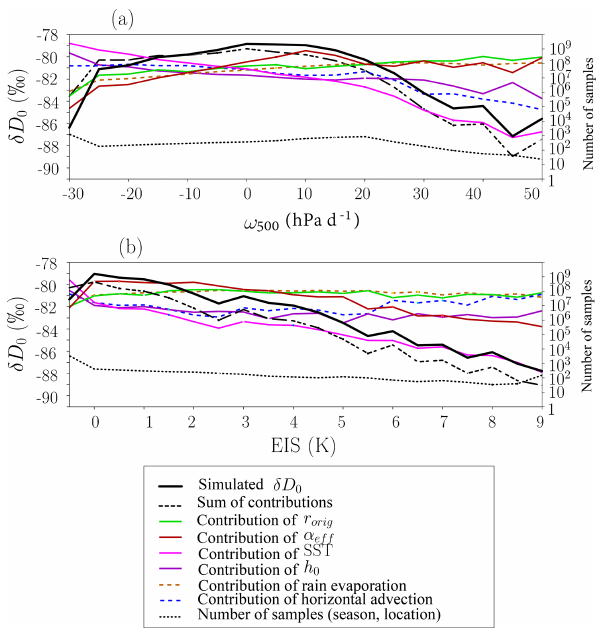
Figure 8. Composites as a function of ω 500 (a) and of EIS (b) of the seasonal averages of δD 0 simulated by LMDZ over all tropi- cal ocean locations (black). Same for the sum of the contributions (black dashed and for each individual contribution to δD 0 : r orig varies (green), α eff (dark red), SST (pink), h 0 (purple), rain evapo- ration (dashed brown), and horizontal advection (dashed blue). The tropical mean δD 0 was added to each contribution to plot on the same scale as simulated δD 0 . The number of samples in each bin is indicated on a logarithmic scale on the right-hand side (dotted black line). Table 3. As in Table 4 but at the daily scale. The correlation co- efficients and slopes are averaged over all seasons and locations over tropical oceans (30 ◦ N–30 ◦ S, ocean fraction > 80%), sepa- rately for ascending and subsiding regimes.